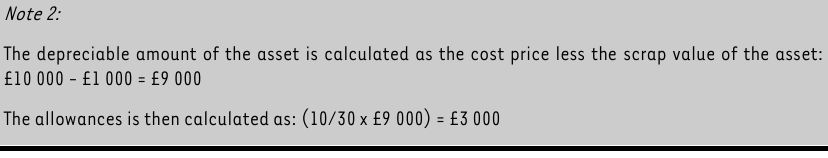
TABLE 2: The UK-CGT effect of a disposal of a wasting asset Note Amount Proceeds of sale £8 000 Less allowable expenditure 1. £7 000 Original cost of asset £10 000 Deduct allowances claimed 2. Chargeable gain £1